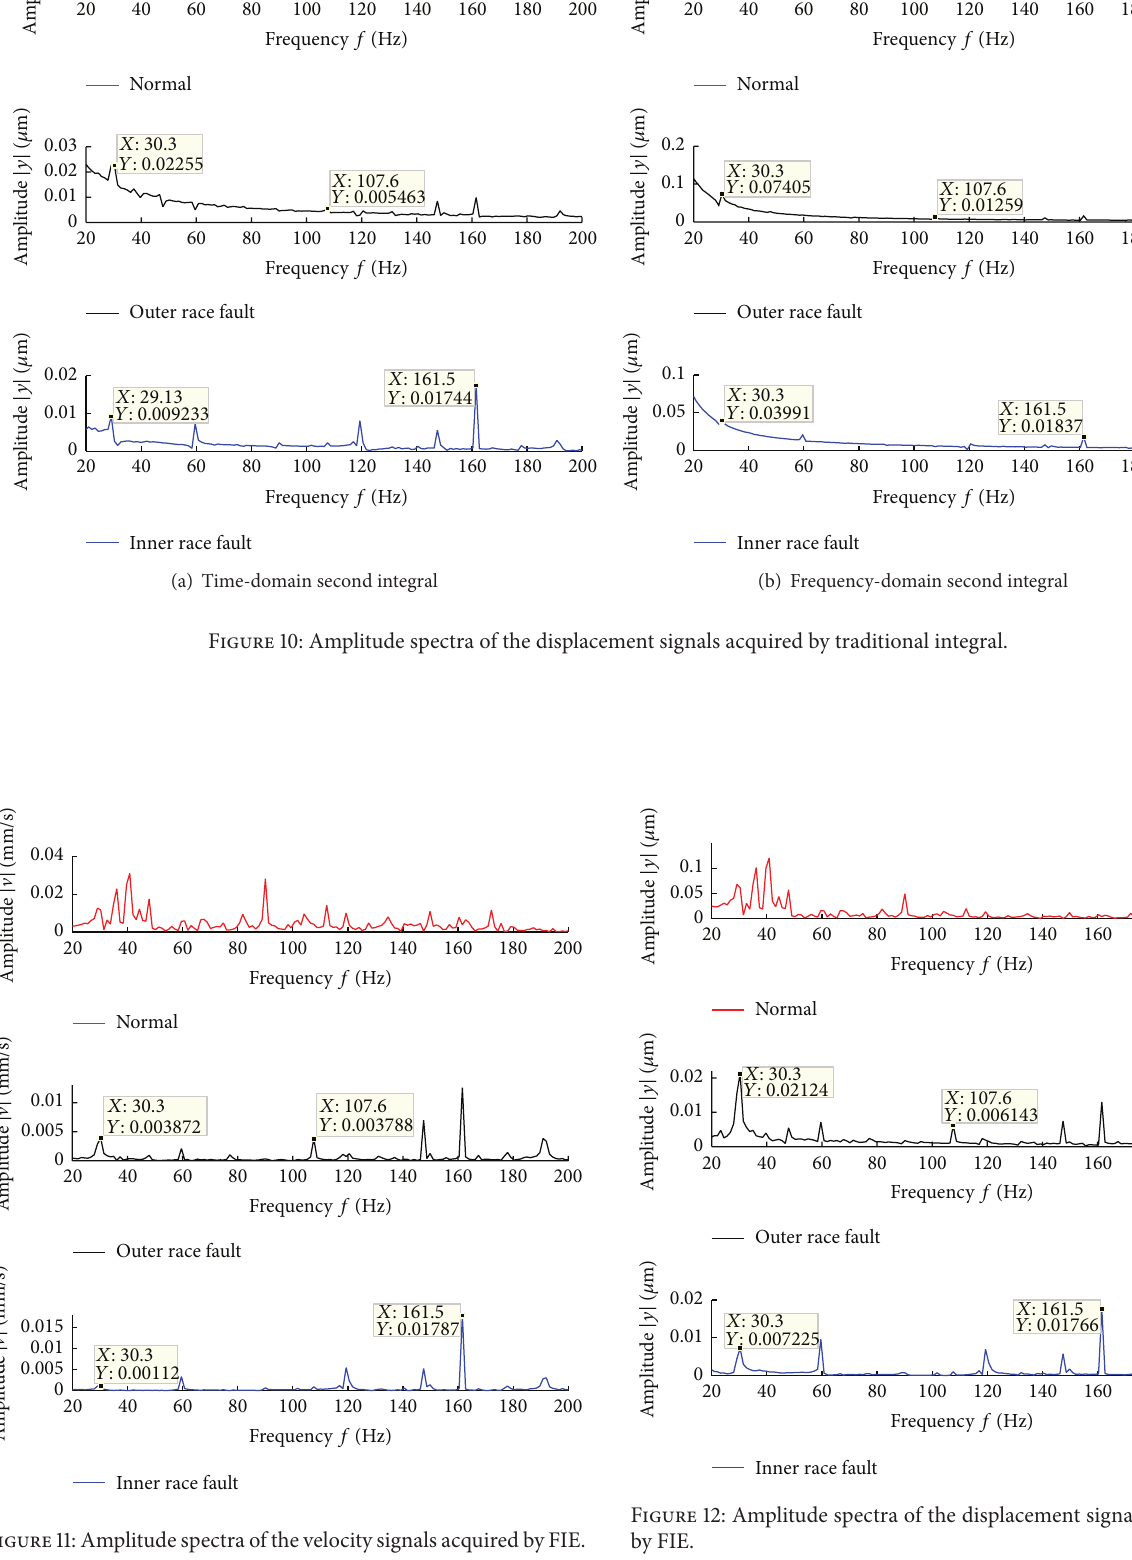
Figure 11: Amplitude spectra of the velocity signals acquired by FIE.